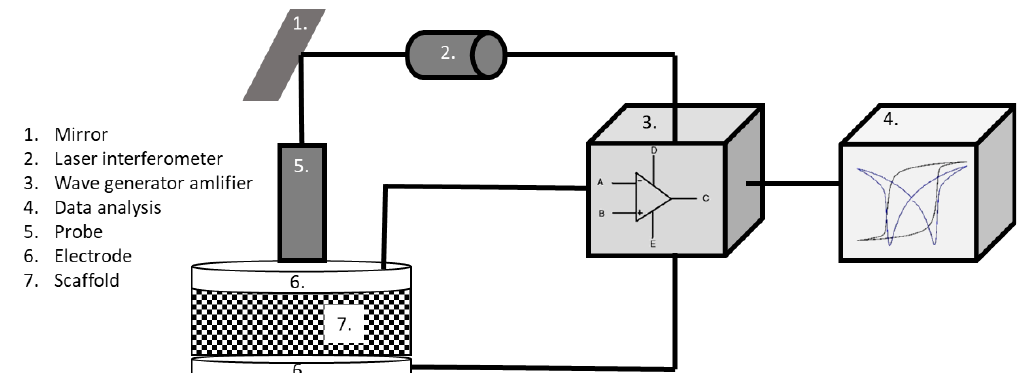
Figure 2. Schematic of the aix PES equipment with a scaffold sample between the electrodes. Low signal analysis (d 33 and ε ) was investigated at low electrical field (<100 V) and 50 Hz. Large signal properties (P-E loop and S-E butterfly curve) were investigated at high electrical fields (up to 2kV) and 0.1 Hz.